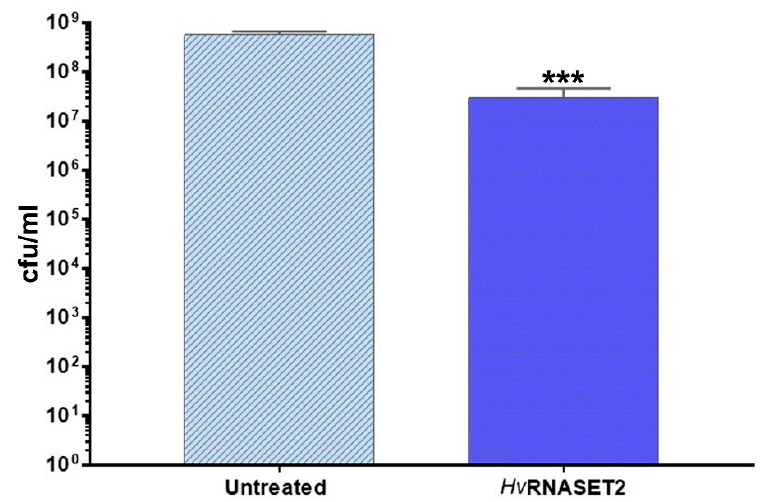
Figure 5. Antimicrobial in vitro assay. The graph illustrates the cellular viability of E. coli after 24 h of r Hv RNASET2 treatment. Untreated cells were used as control. Experiments were performed in triplicate, and statistical differences were calculated by unpaired t -test. *** p < 0.001 indicates a significant difference with untreated samples.